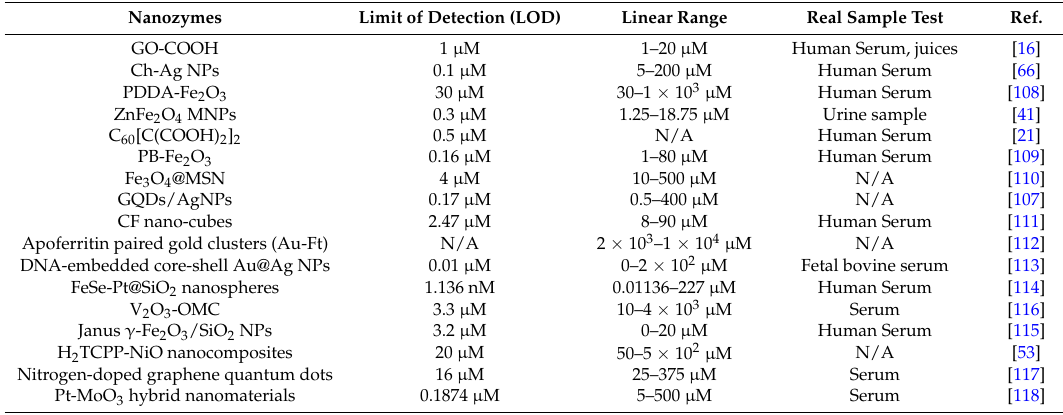
Figure 5. Colorimetric detection of glucose by using GOx catalyzed reaction ( A ) and Pt-MoO 3 hybrid nanomaterials as catalysts ( B ) [118]. Table 2. Analytical performance comparison of the multi component nanozyme methods for the detection of glucose.